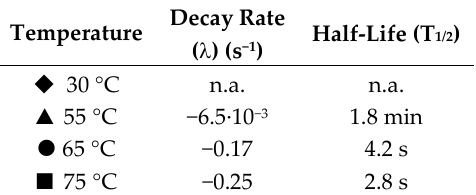
Figure 7. Plot of residual activity against incubation time; the decay rate  was determined as the slope of a linear fit during the degradation phase (see Table 5). ◆ 30 °C, ▲ 55 °C,  65 °C and ■ 75 °C incubation temperature. Data points with empty symbols were not taken into account for the calculation of the decay rate. Table 5. Decay rate  and half-life T 1/2 at 30 °C, 55 °C, 65 °C and 75